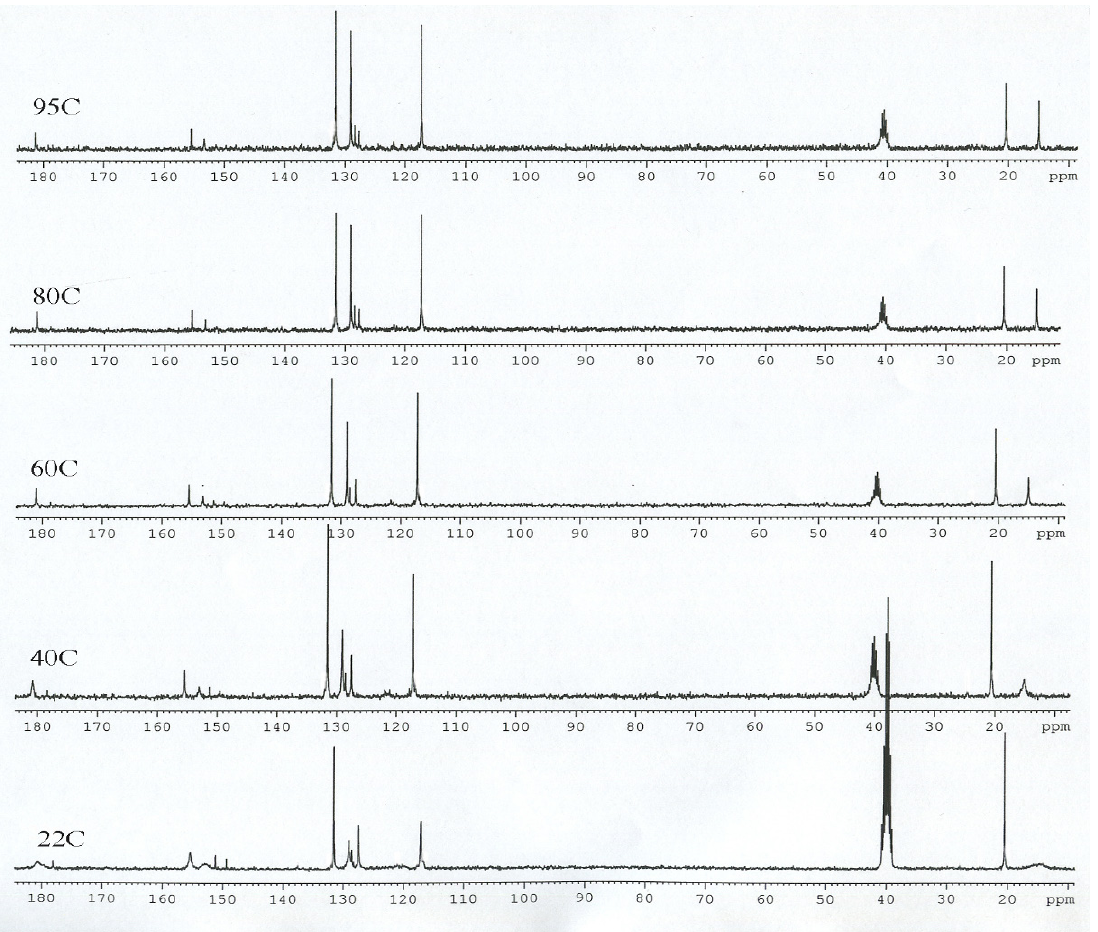
Figure 1. 13 C NMR spectrum of ( E )-2-hydroxy-5-metylace to phe none thiosemicarbazone ( II ) in 10% solutions DMSO-d